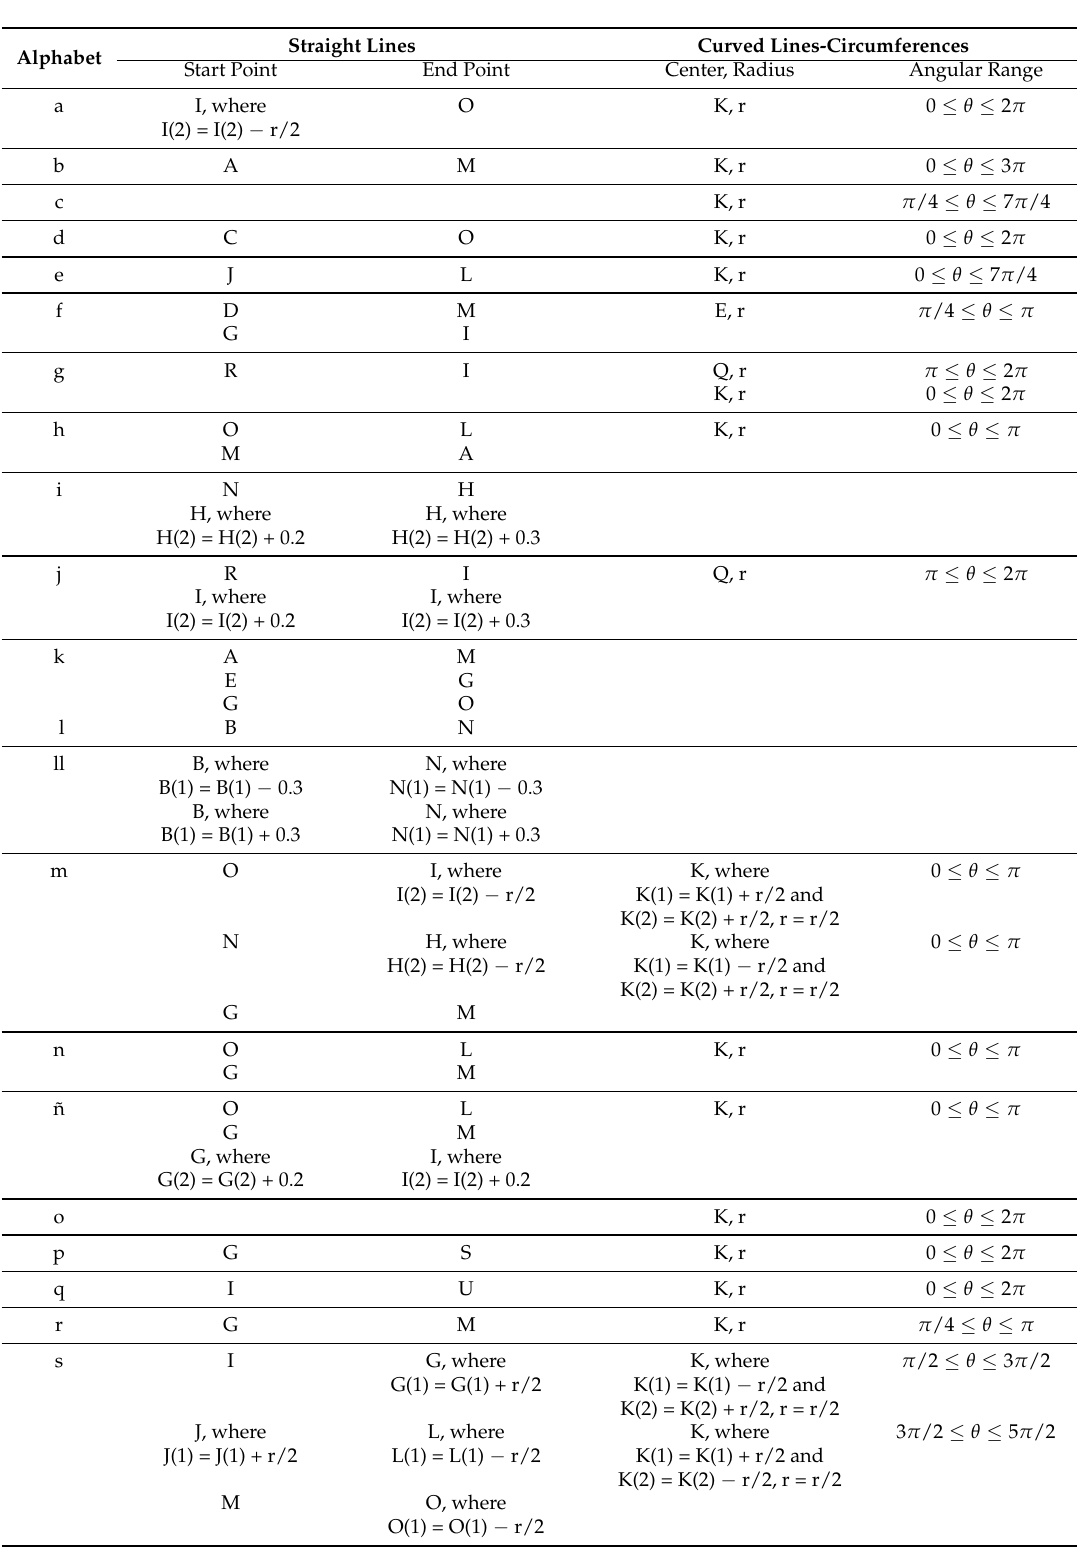
Table 1. Start-end points for the creation of the Mexican Spanish alphabet characters: (1) = x coordinate of a point, (2) = y coordinate of a